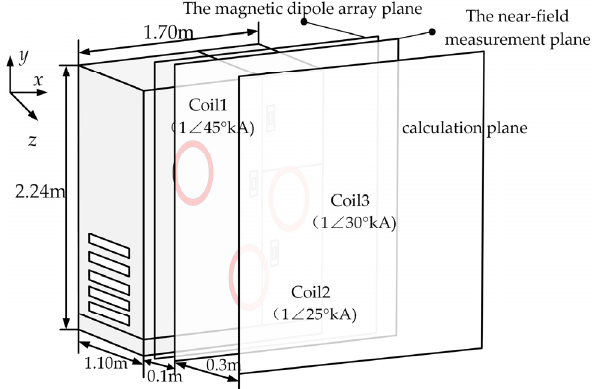
Figure 10. Electronic cabinet model in the Maxwell3D.